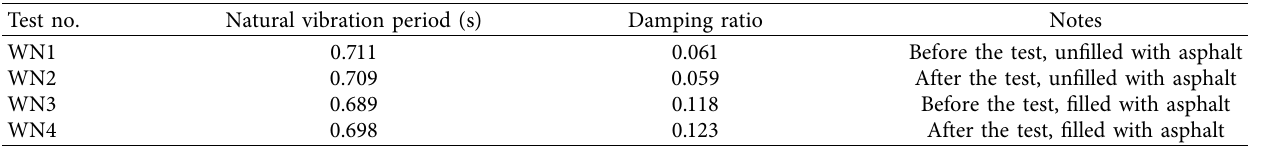
Figure 7: Acceleration and displacement time history: (a) WL0, (b) Taft0, (c) WL1, (d) WL2, (e) WL3, (f) Taft1, and (g) Taft2. Table 2: Natural vibration period and damping